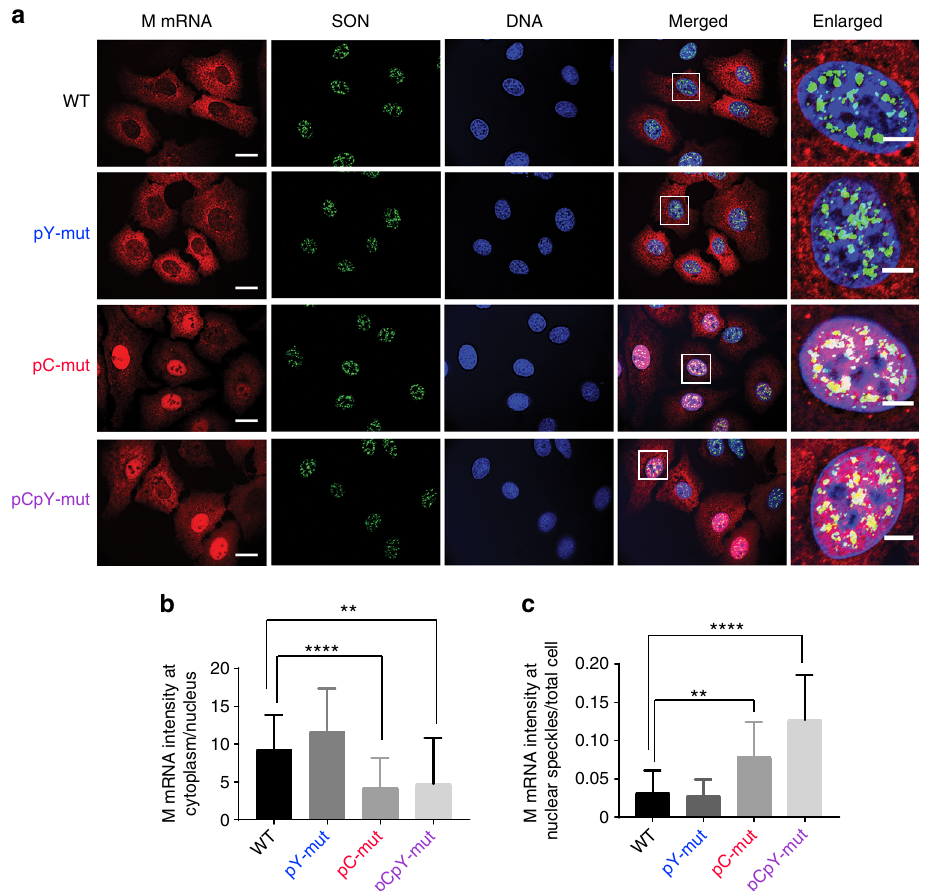
Fig. 5 Mutation of hnRNP K but not NS1-BP-binding sites alters M mRNA localization. a A549 cells were infected with wild type (WT) and mutant A/WNS/33 viruses at MOI 5. After 8.45 h infection, cells were subjected to RNA-FISH combined with immuno fl uorescence to detect M mRNA and SON protein. SON protein is a marker for nuclear speckles. Scale bar, 20 µ m. The marked rectangular region is enlarged and shown in the right-most panel. Scale bar, 5 µ m. Images are representative of at least 12 images from biological triplicates. b Quanti fi cation of M mRNA intensity in the cytoplasm (C) and in the nucleus (N) expressed as C/N ratios. Values are mean ± s.d. measured in at least 25 cells. c Quanti fi cation of M mRNA intensity at nuclear speckles with respect to total cell intensity. Values are mean ± s.d. measured in at least 25 cells. Statistical signi fi cance was determined via two-tailed student ’ s t test, where ** p < 0.01 and **** p < 0.001 when comparing mock vs. mutant